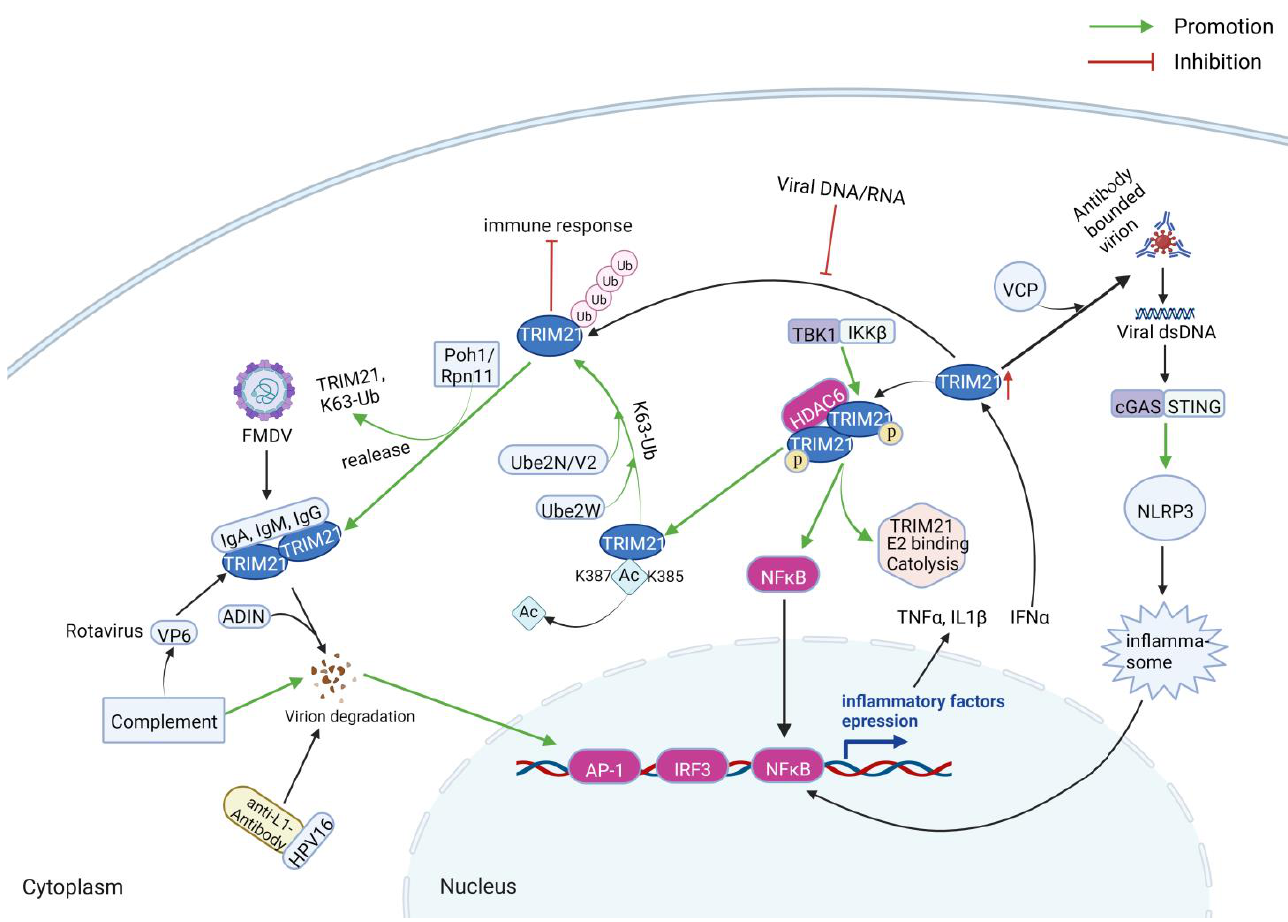
Figure 8. TRIM21 serves as a cytosolic Fc receptor. TRIM21 is a high-affinity cytosolic IgG receptor, which can bind with the antibody–virus complex and induce an indirect antiviral antibody-dependent intracellular neutralization (ADIN) and virion degradation via the ubiquitin–proteasome pathway. Figure created with BioRender.com.